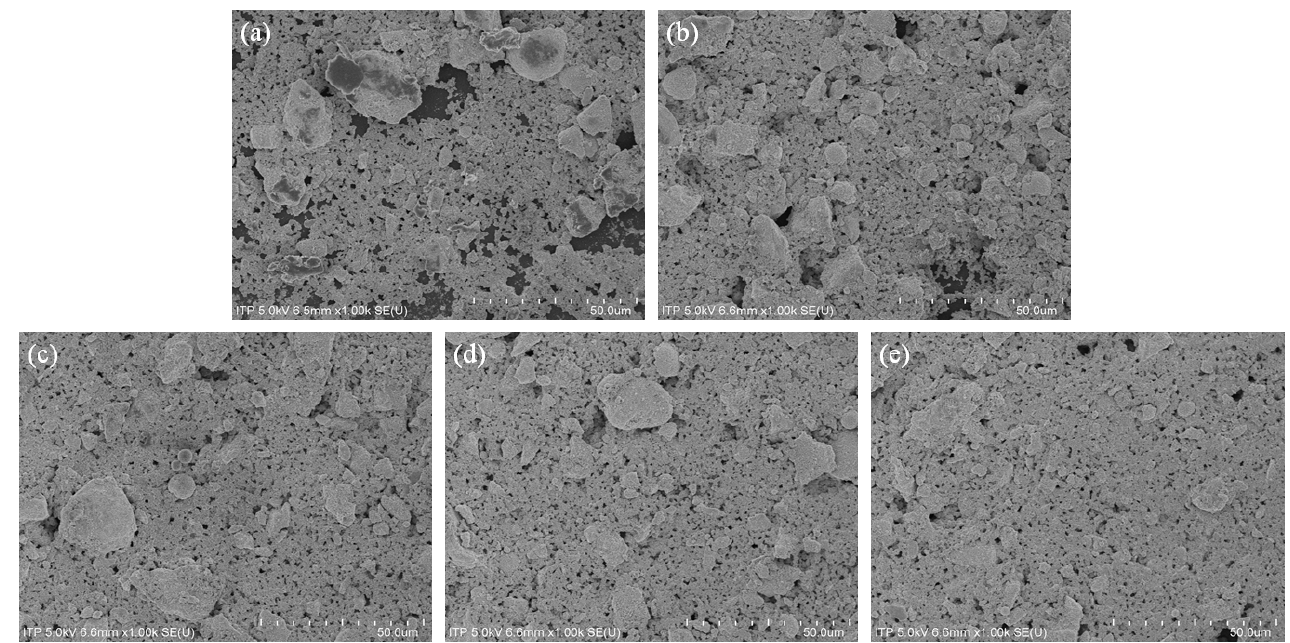
Figure 5. SEM results according to each step to confirm the arrangement of particles for steps ( a ) 1, ( b ) 2, ( c ) 3, ( d ) 4, and ( e ) 5.